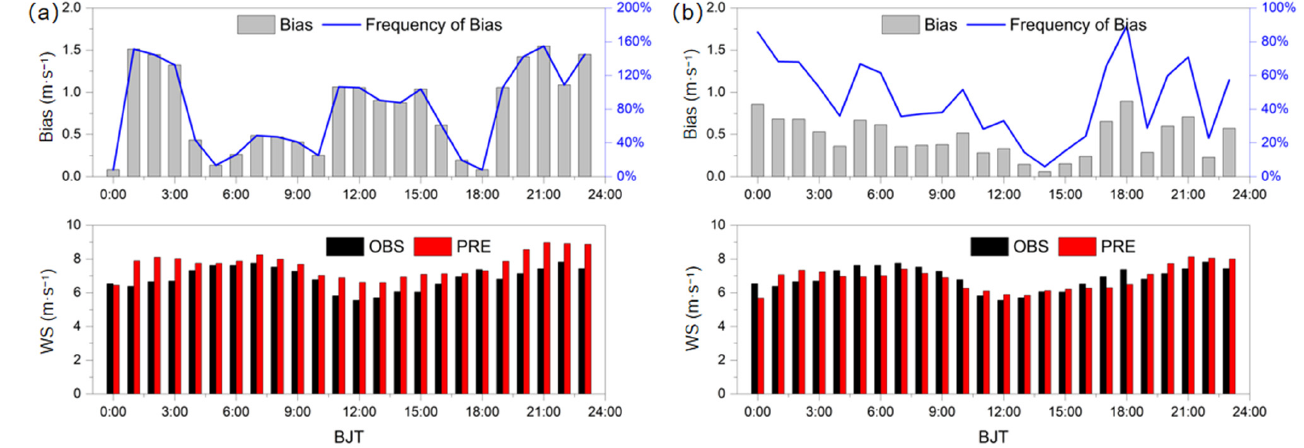
Figure 6. Hourly wind speed correction of nearest replacement result using AVT methodology. Panel ( a ) is the result before AVT correction; panel ( b ) is after AVT correction.